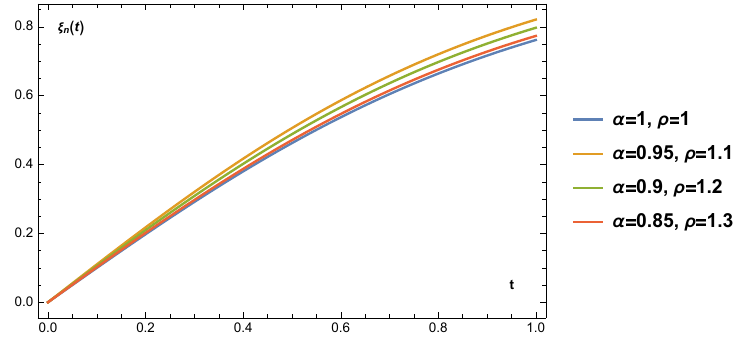
Figure 1. The absolute error graph of Example 1, for α = β = ρ = 1 and n = 18.